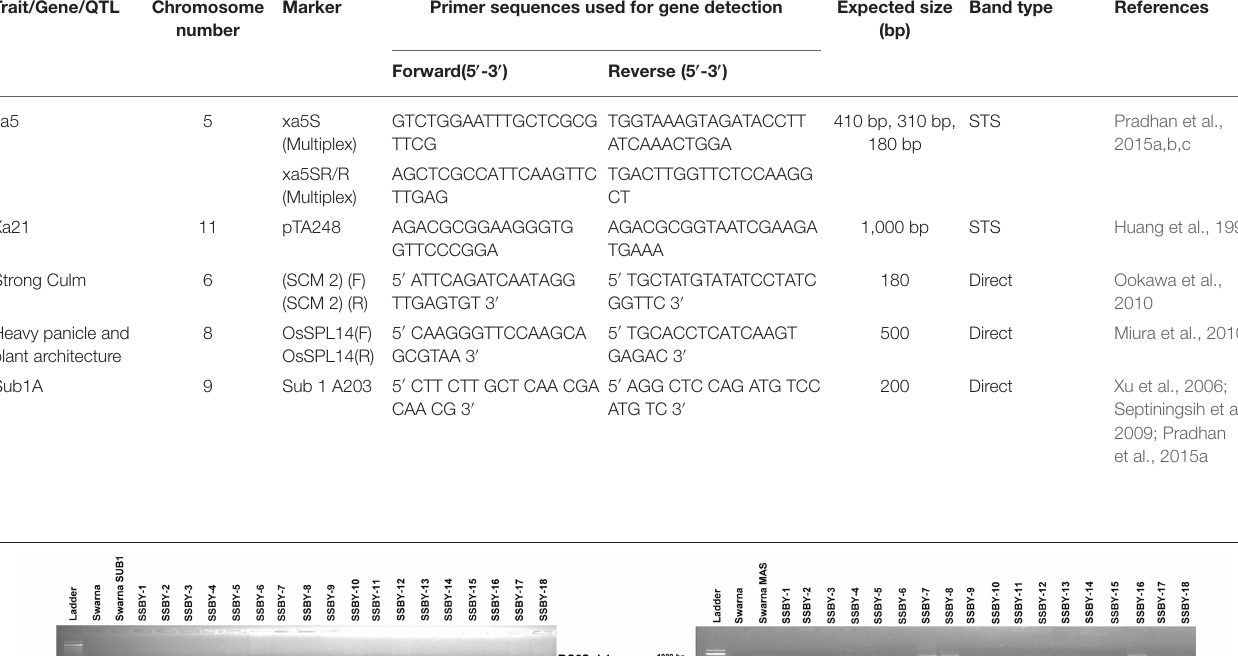
TABLE 1 | Molecular markers used for tracking yield component, submergence tolerance QTL, and bacterial blight resistance genes in the backcross progenies. Trait/Gene/QTL